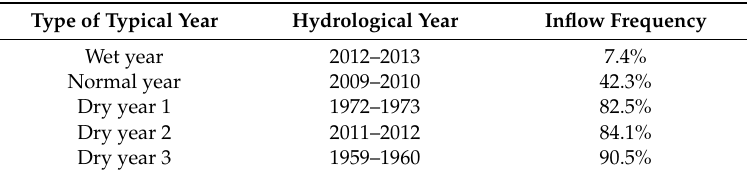
Table 3. Selected five typical years and their inflow frequency.